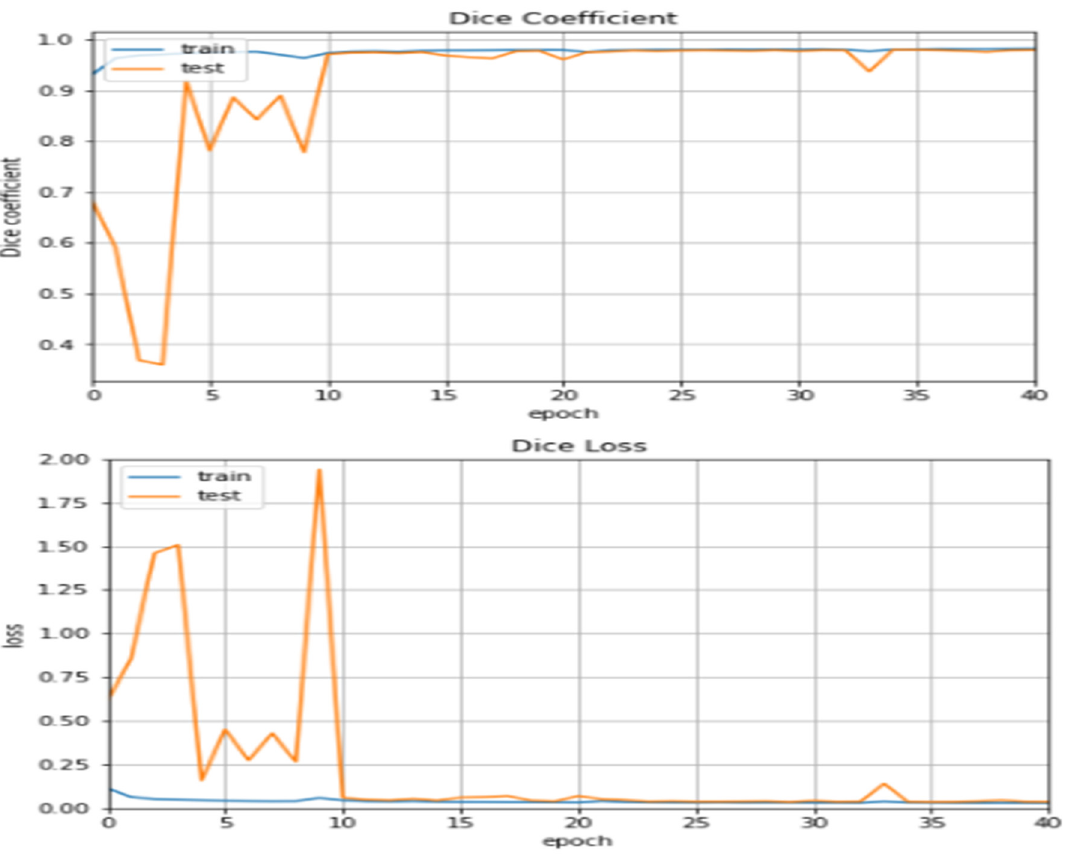
Figure 9. Dice Coefficient and Dice Loss Training curves of the lung’s segmentation model.